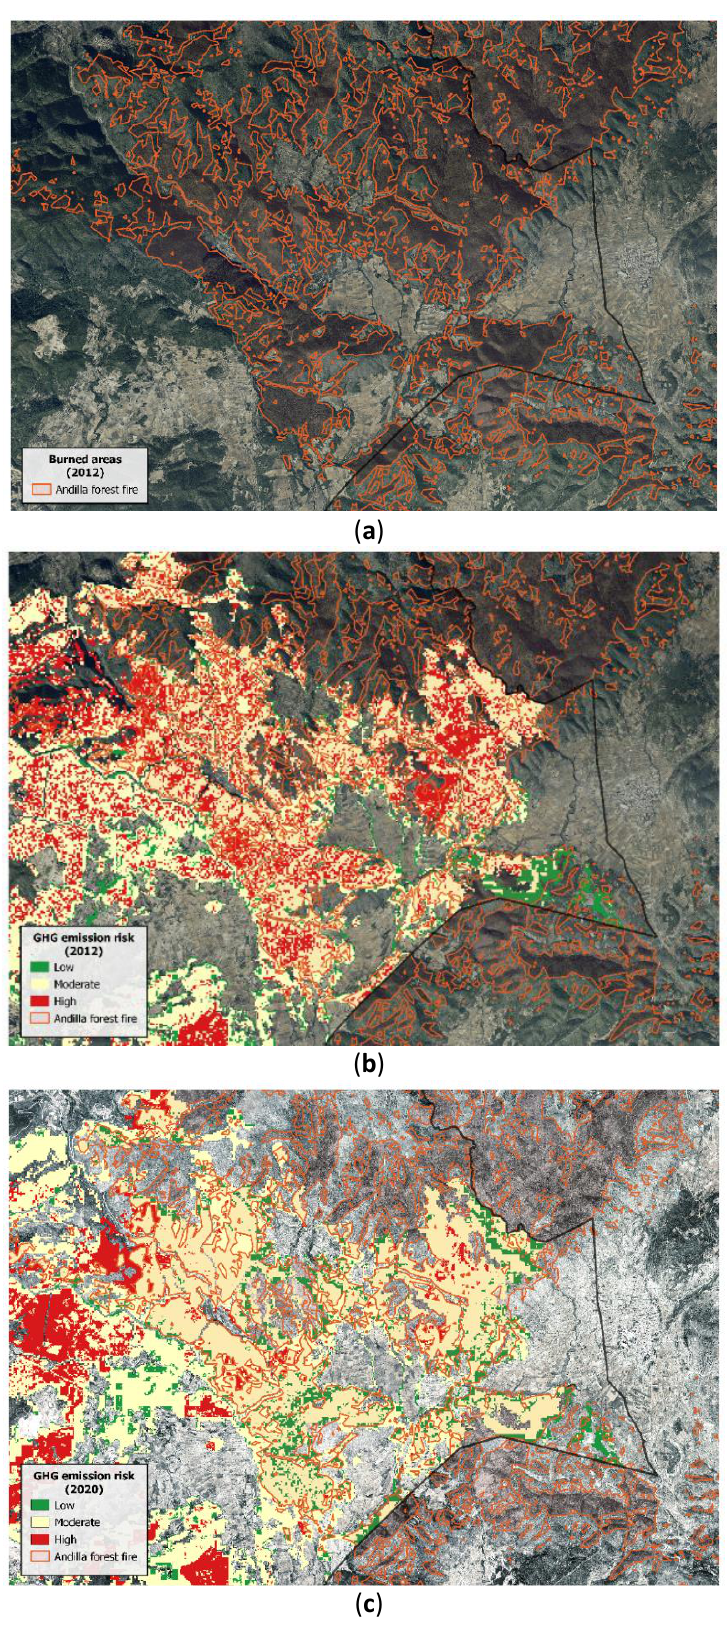
Figure 5. ( a ) Scale up of Andilla forest fire (2010 orthophoto). ( b ) GHG emission risk in 2012. ( c ) GHG emission risk in 2020 (2020